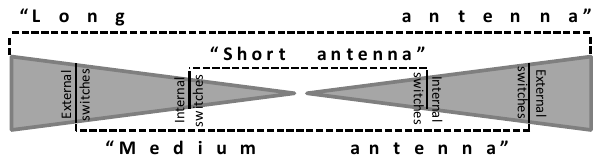
Figure 2. Non-quantitative scheme for the reconfigurable anten- nae: the antennae are “short” if all the switches are set off, they are “medium” if the internal switches are set on and the external ones are set off, they are “long” if all the switches are set